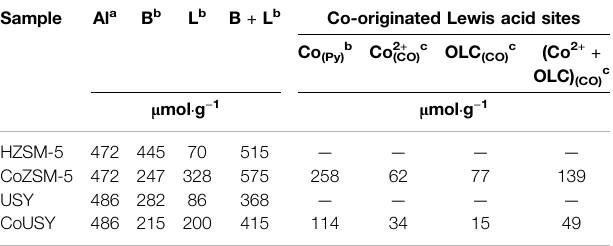
TABLE 2 | The content of Al, Brønsted (B), and Lewis (L) acid sites, in studied samples (Co-catalysts and reference zeolites) together with the content of Co species such as Co 2+ ions and oxide-like cobalt forms (OLC) in the CoZSM-5 and Co-USY catalysts.